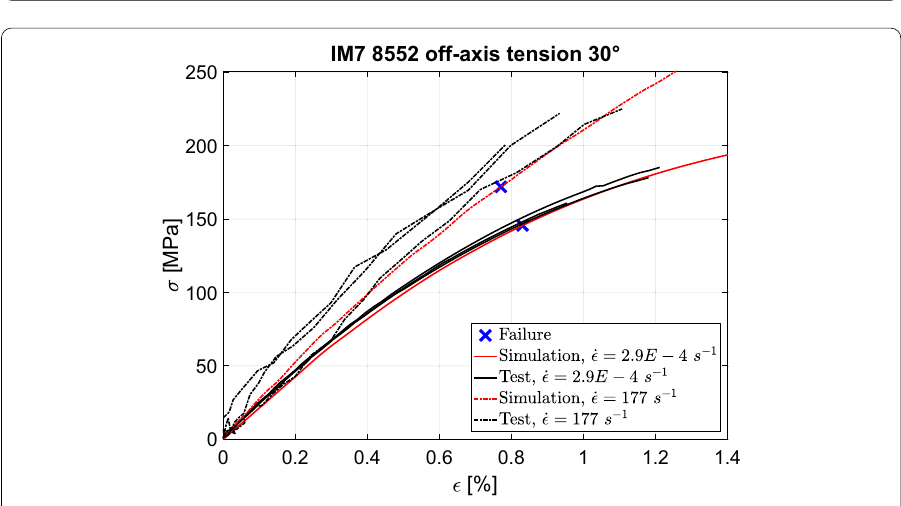
Fig. 13 True stress–true strain curves for the tensile tests and simulations, 30